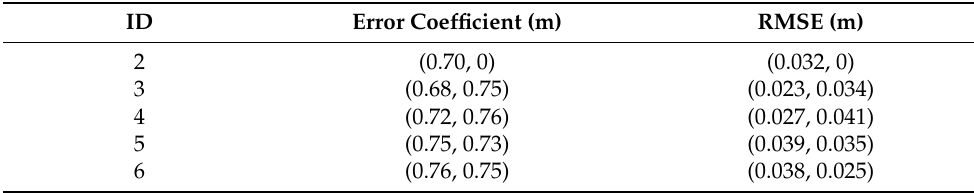
Table 3. Base stations coordinate error coefficient and root mean square error.